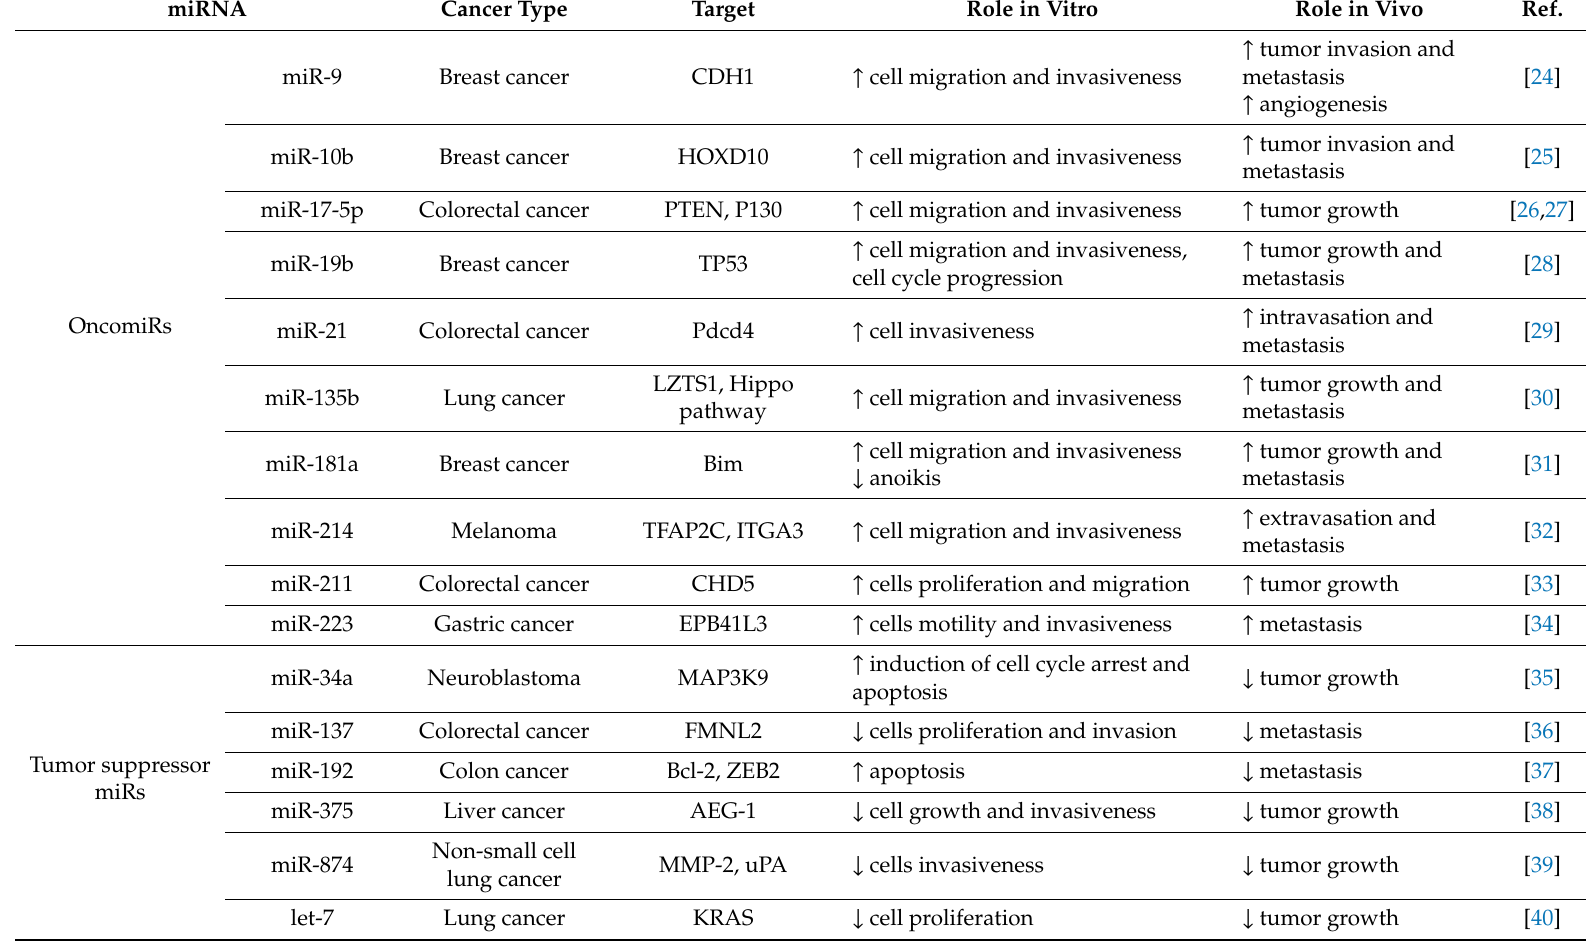
Table 1. Role of miRNAs in cancer